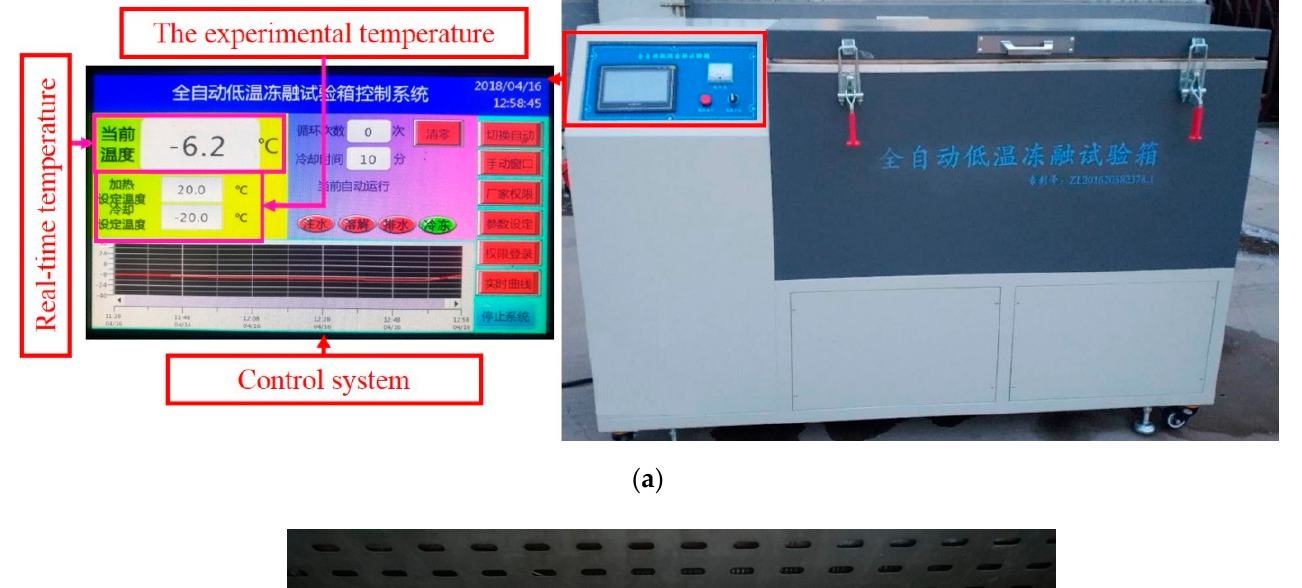
Figure 1. Non-persistent jointed rock specimen. ( a ) Jointed rock specimens. ( b ) Schematic diagram of the jointed rock specimen.